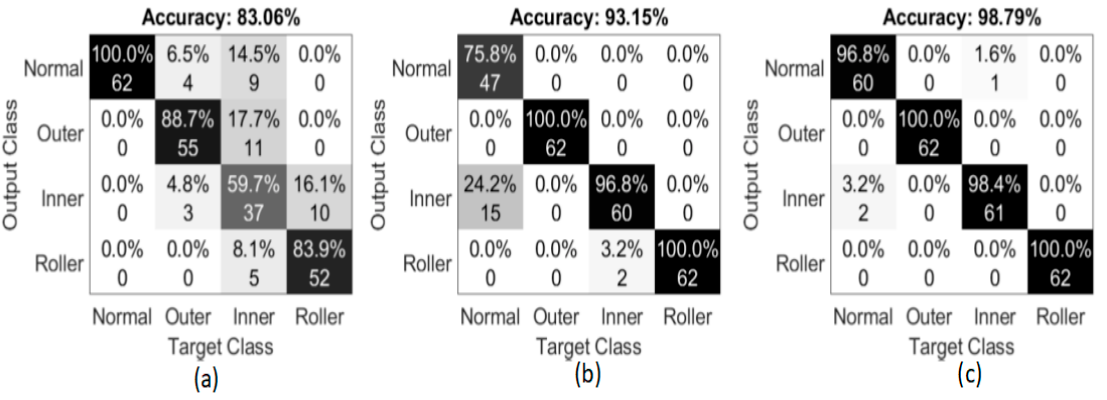
Figure 7. The confusion matrix for the test dataset with the proposed DCNN using different types of input image: ( a ) Vibration image ( b ) Conventional Wavelet spectrogram image ( c ) DSWI.